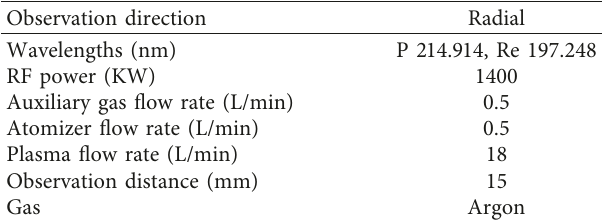
Table 2: Operating conditions of ICP-OES.